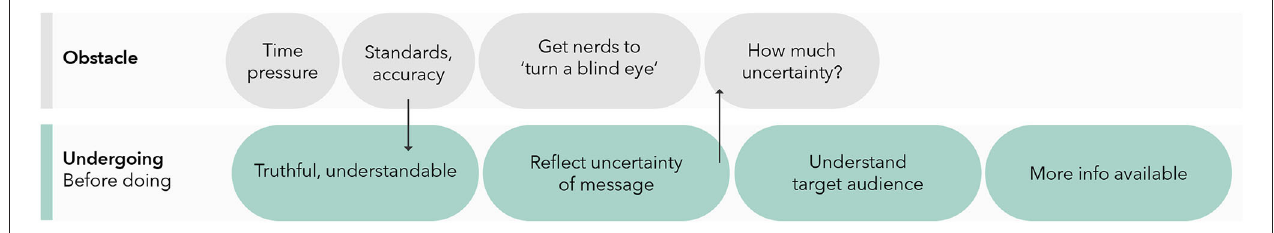
FIGURE 3 | A flow chart representation of creative activity as explained by public health professionals.